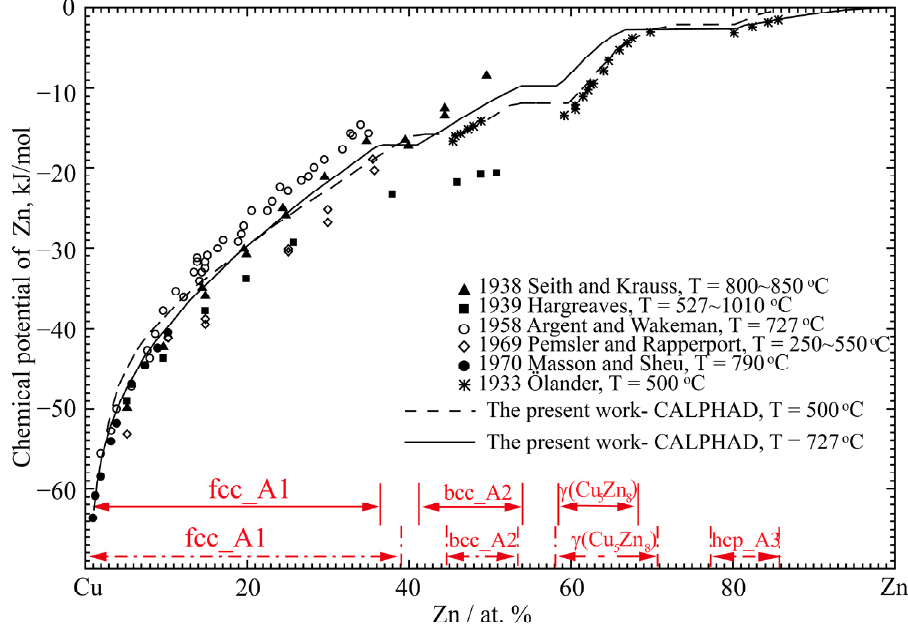
Figure 6. The calculated chemical potential of Zn for the solid phases at 500 and 727 °C in the Cu-Zn system compared with the experimental data from refs. [76–81].